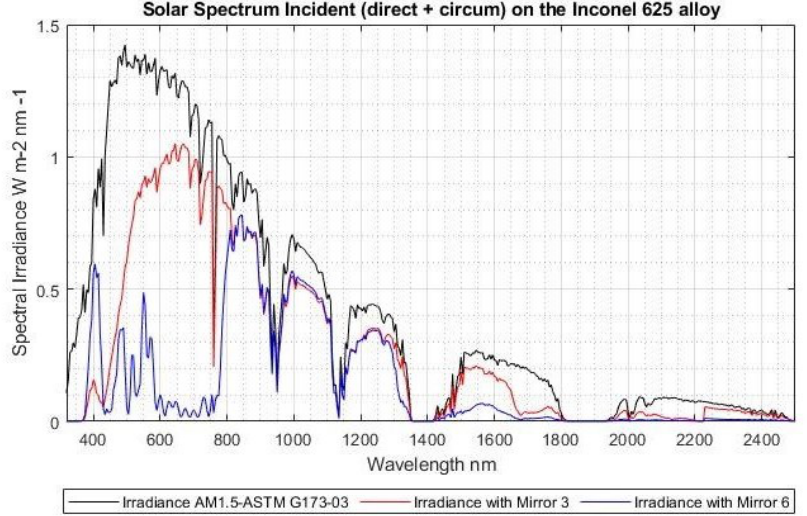
Figure 9. Filtered solar Spectral irradiance of mirrors #3 and #6 with respect to the irradiance of the standard AM1.5 solar